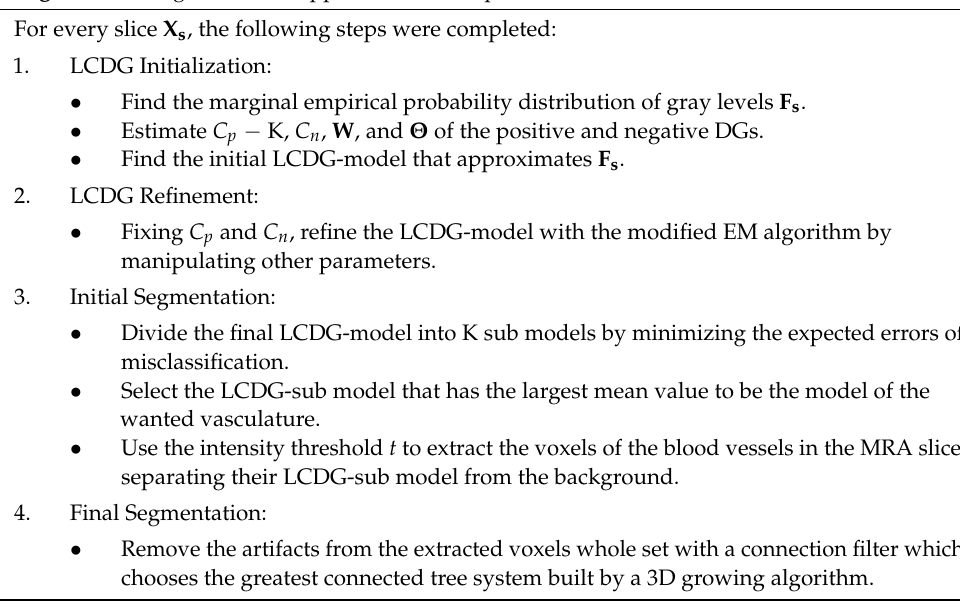
Algorithm 1. Segmentation Approach Main